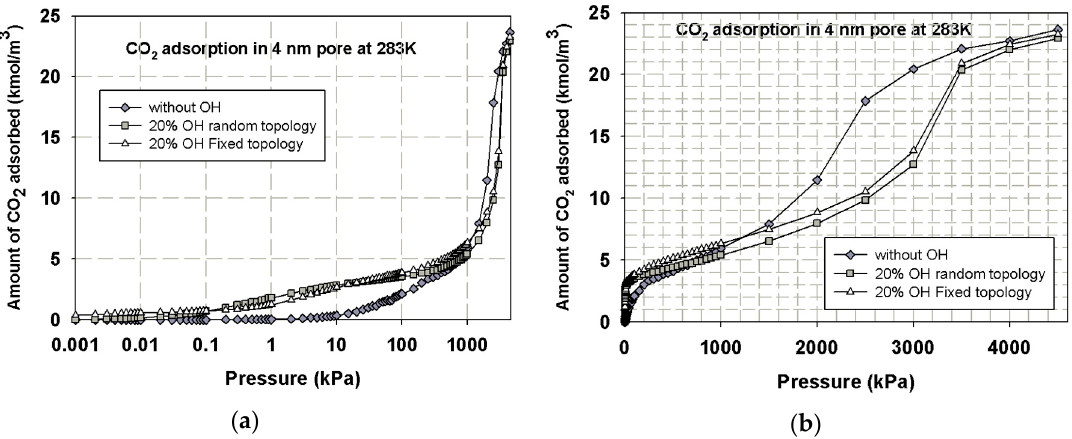
Figure 14. Effects of functional group allocation on CO 2 adsorption isotherms at 283 K for the porous silica model of 4 nm widths at ( a ) plotted in semi - log scale and ( b ) plotted in linear scale .